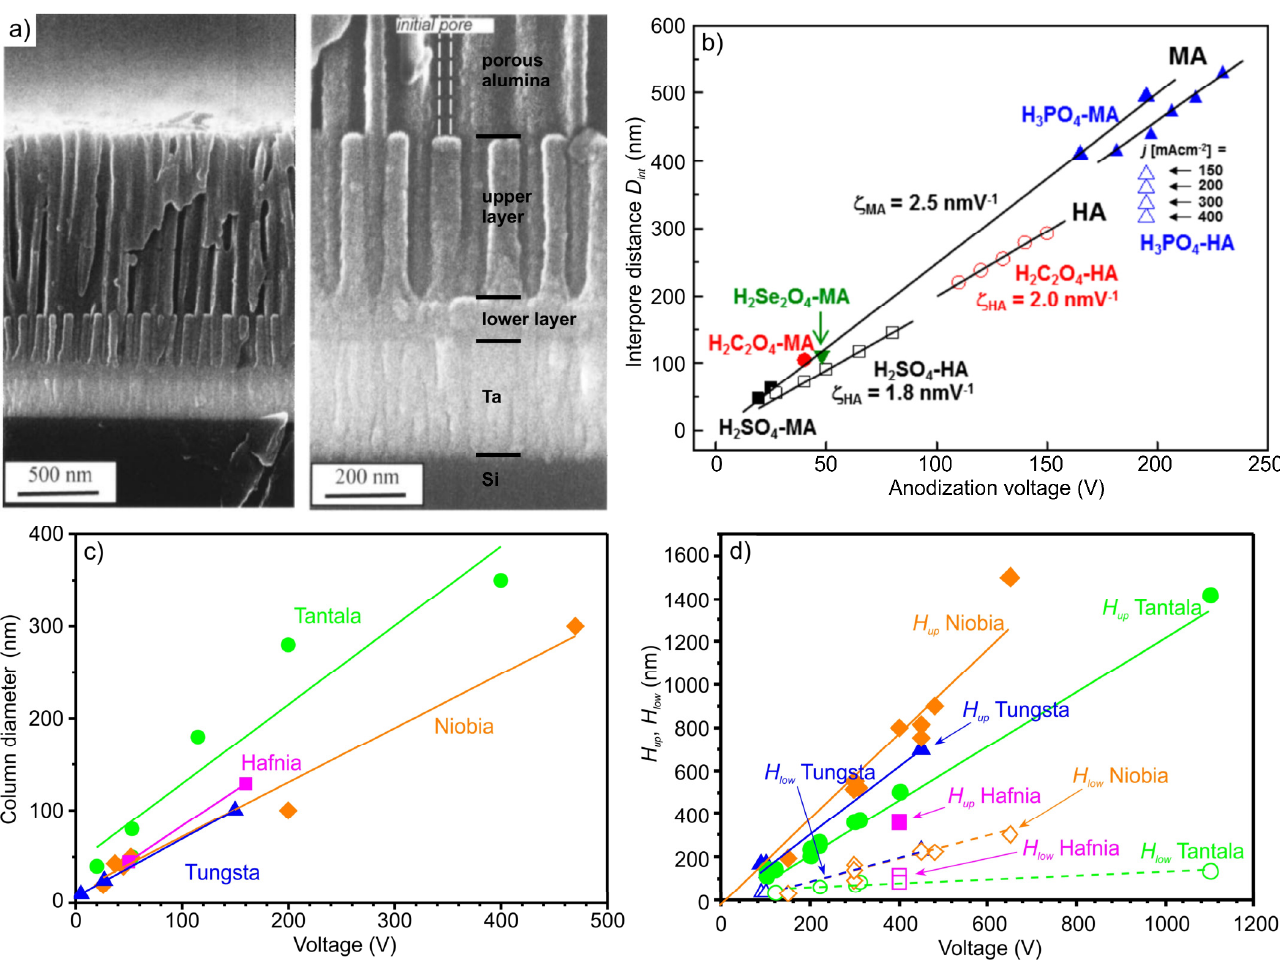
Figure 1. ( a ) SEM images of one-level column-like nanofilm morphology reproduced from Ref. [27]. ( b ) Anodizing voltage influence on PAA cell size (interpore distance) by using H 2 SO 4 (black symbols), H 2 C 2 O 4 (red symbols), H 2 SeO 4 (green symbol), and H 3 PO 4 (blue symbols), MA: mild anodizing, filled symbols, and HA: hard anodizing, void symbols; reproduced from Ref. [29]. ( c , d ) Size dependence of tantala, niobia, tungsta and hafnia continuous layer, column diameter and height from reanodizing voltage taken from Refs. [1–3,5,6,8,9,11,14,17–32]. Table 1 . Magnetic and dielectric constant of tantala, niobia, hafnia, tungsta.